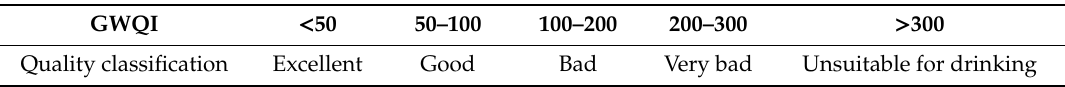
Table 3. Water quality classification based on the weighted groundwater quality index (GWQI) for human consumption. GWQI